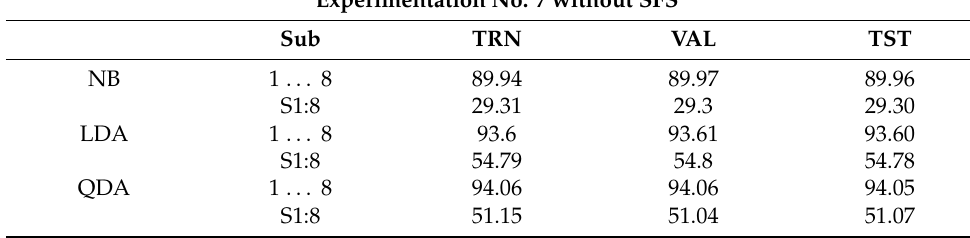
Table 8. Experimentation 8: The format of the table is the same as Table 6, with the number of features selected for each subset of tests from SFS; normalization was applied to the data before they were used to create the